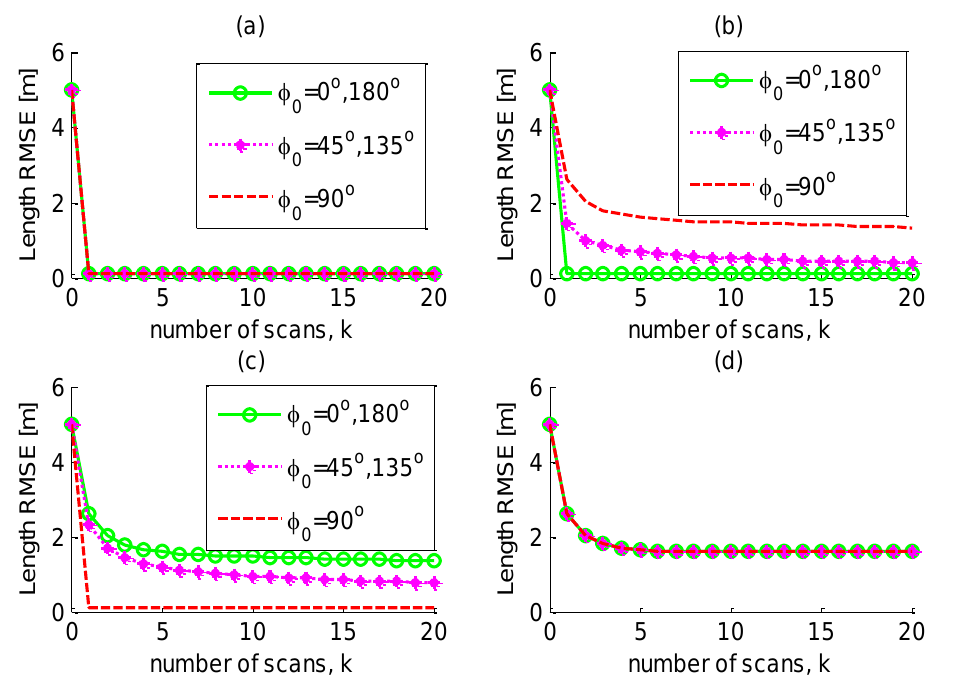
 on the PCRLB curves for different values of 0